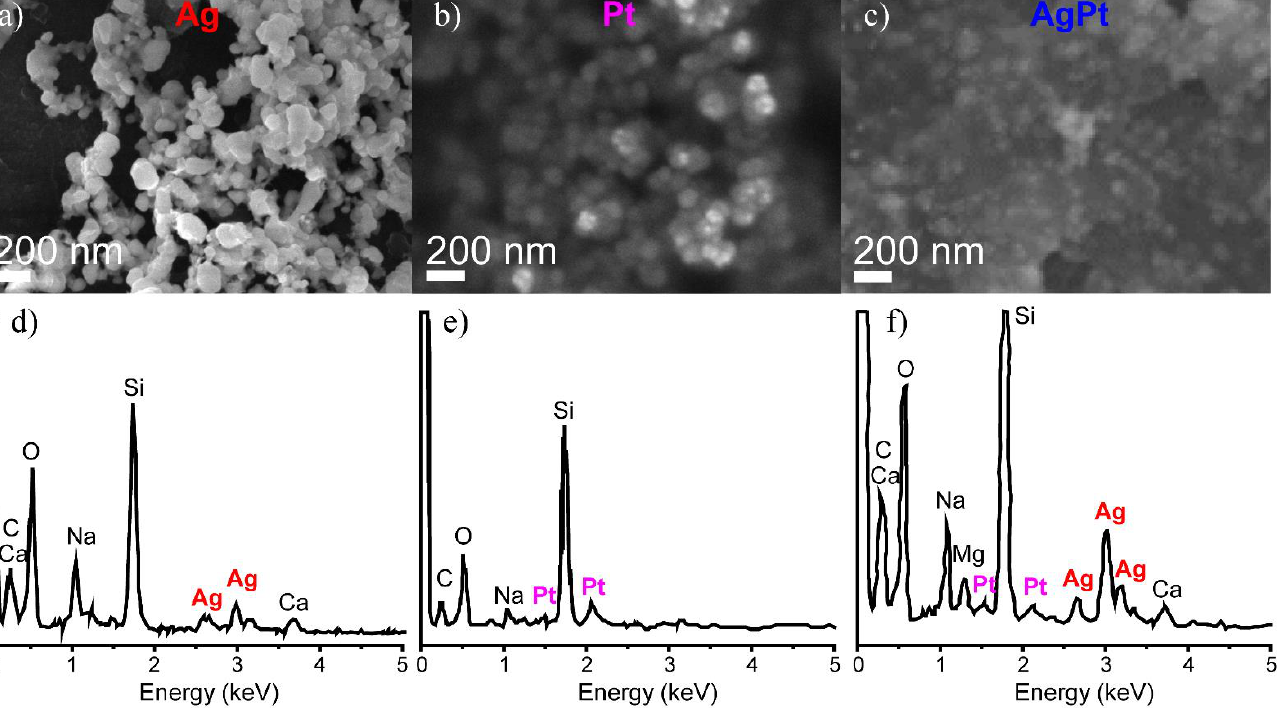
Figure 2. SEM images of LID on PANI with ( a ) C 7 H 5 AgO 2 , ( b ) Pt(NH 3 ) 4 (OH) 2 , and ( c ) C 7 H 5 AgO 2 +Pt(NH 3 ) 4 (OH) 2 solutions. EDX analysis of LID on PANI with ( d ) C 7 H 5 AgO 2 , ( e ) Pt(NH 3 ) 4 (OH) 2 , and ( f ) C 7 H 5 AgO 2 +Pt(NH 3 ) 4 (OH) 2 solutions.